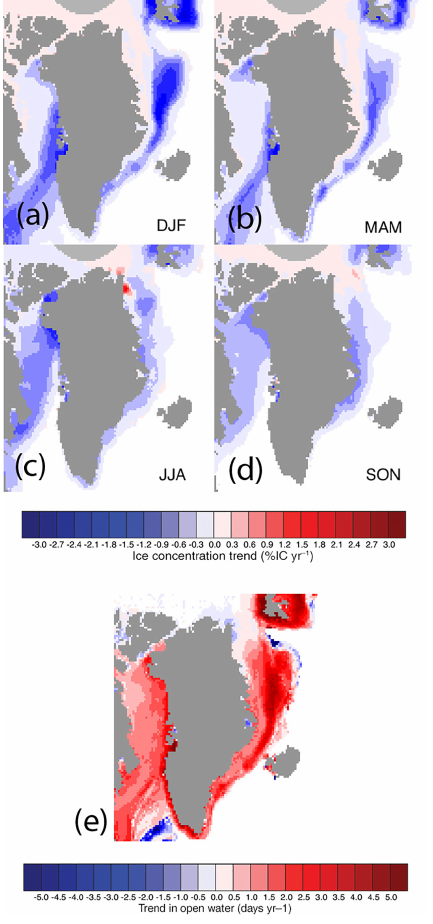
Figure 4. Seasonal trends in sea ice concentration from 1979 to 2015 (a–d) and number of ice-free days (e) . Trends are computed using linear least squares and evaluated using Student’s t test at 95 % confidence interval.